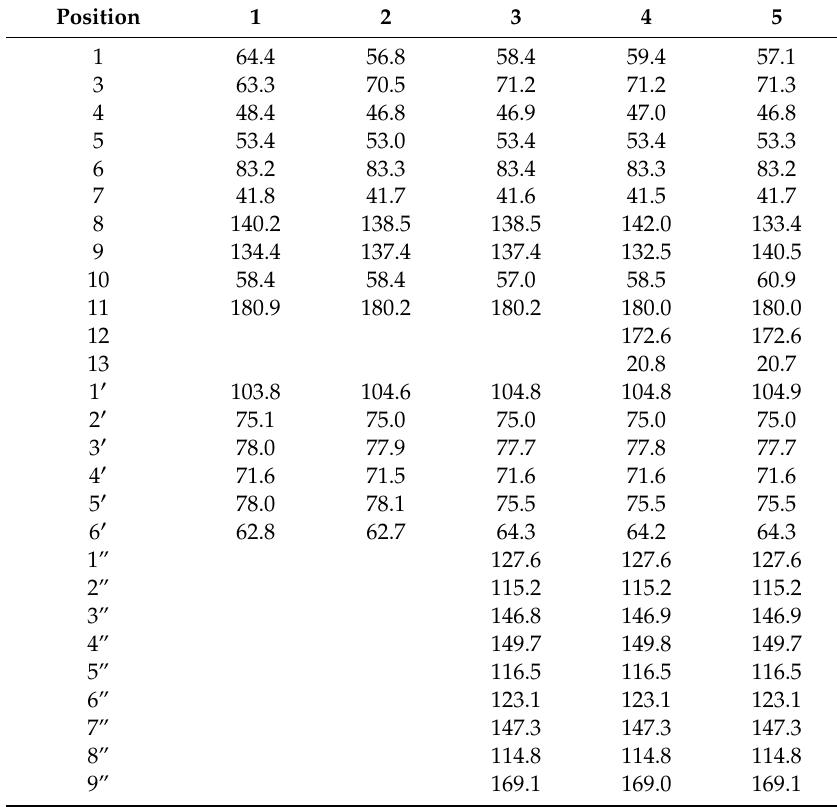
Table 2. 13 C-NMR data of compounds 1 – 5 (175 MHz, CD 3 OD, δ in ppm).